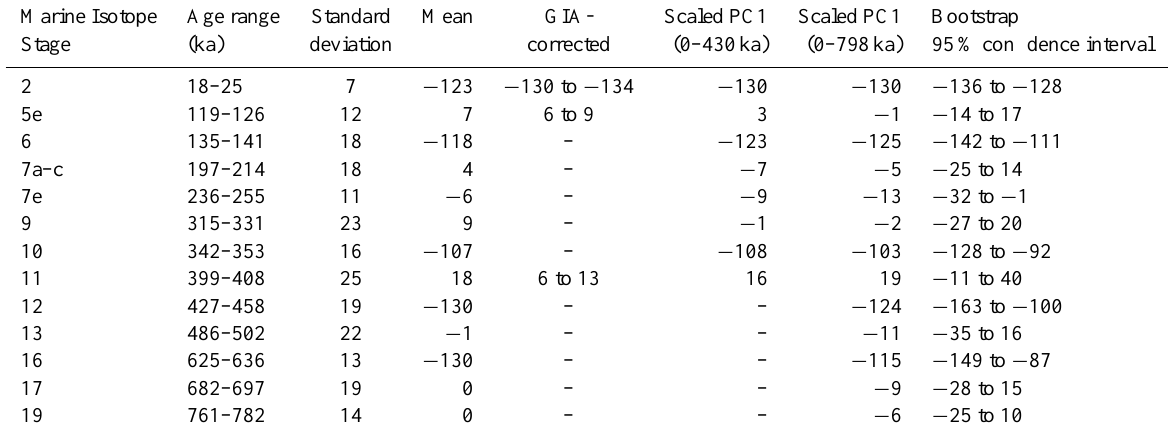
Table 3. Mean and standard deviation of sea level highstand and lowstand estimates (in meters above modern) from Table 2 compared to scaled PC1 and GIA-corrected estimates from corals and other coastal proxies. GIA-corrected estimates for MIS 2 are from Clark et al. (2009) and Lambeck et al. (2014), for MIS 5e from Dutton et al. (2015), and for MIS 11 from Raymo and Mitrovica (2012). Bootstrap 95% confidence intervals are from sampling the seven-record-short PC1 for MIS 2–11 and from the five-record-long PC1 for MIS